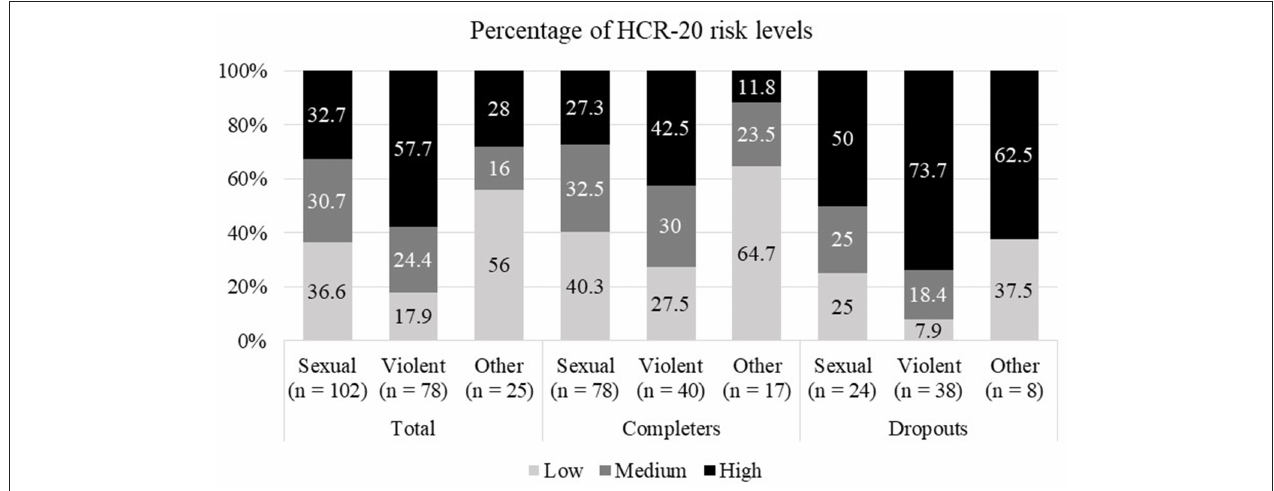
FIGURE 1 | Relative distribution of HCR-20 risk levels for offender group and dropout status.